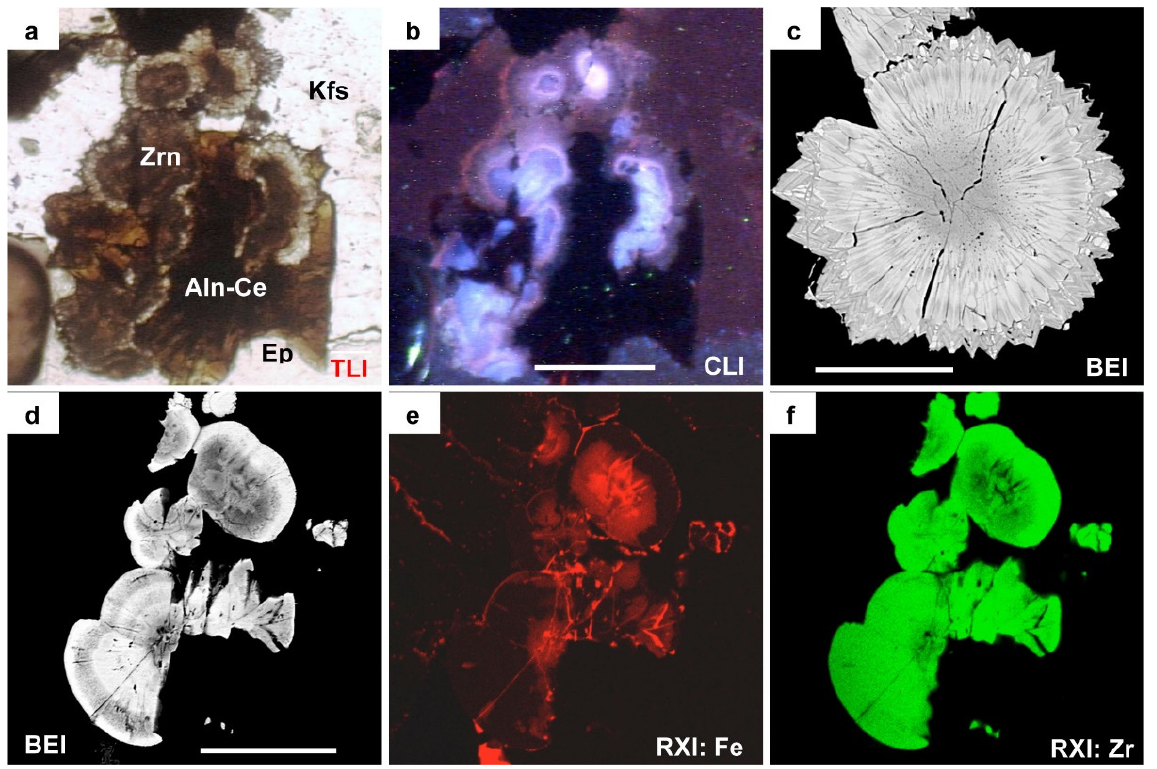
Figure 3. Images and compositional maps of hydrothermal zircon aggregates in peralkaline granite from the Corupá Pluton. Botryoidal zircon aggregate associated with fibro-radiated allanite-(Ce) and ferriallanite-(Ce) (Aln-Ce, dark brown) + epidote (Ep, green) aggregates between K-feldspar (Kfs) crystals. ( a ): Transmitted light image emphasizing the brown nuclei and the colorless better- crystallized zircon overgrowths; ( b ): Cathodoluminescence image displaying zonal and concentric arrangement of light blue, slightly violet, and red colors in zircon. Allanite-(Ce), ferriallanite-(Ce) and epidote are represented in black. ( c ): BSE image of spherulitic, crypto-to-microcrystalline fibro- radiated zircon aggregate with concentric zoning pattern and minute dark spots (Fe-oxide inclusions and/or micro-pores) accompanying the zoning and crystal fibers arrangements; note the idiomorphic pyramidal termination of the fibers. ( d ): BSE image of lenticular and semi-lenticular cryptocrystalline aggregates with concentric zoning pattern. ( e , f ): X-ray dot maps for Fe ( e ) and Zr ( f ) of the aggregates shown in ( d ); note the Fe-rich and Zr-poor irregular nuclei surrounded by a more regular and less Fe-rich, Zr-poor zone and then by a relatively Fe-poor and Zr-rich external zone. White bars measure 50 µ m. See text for discussion.